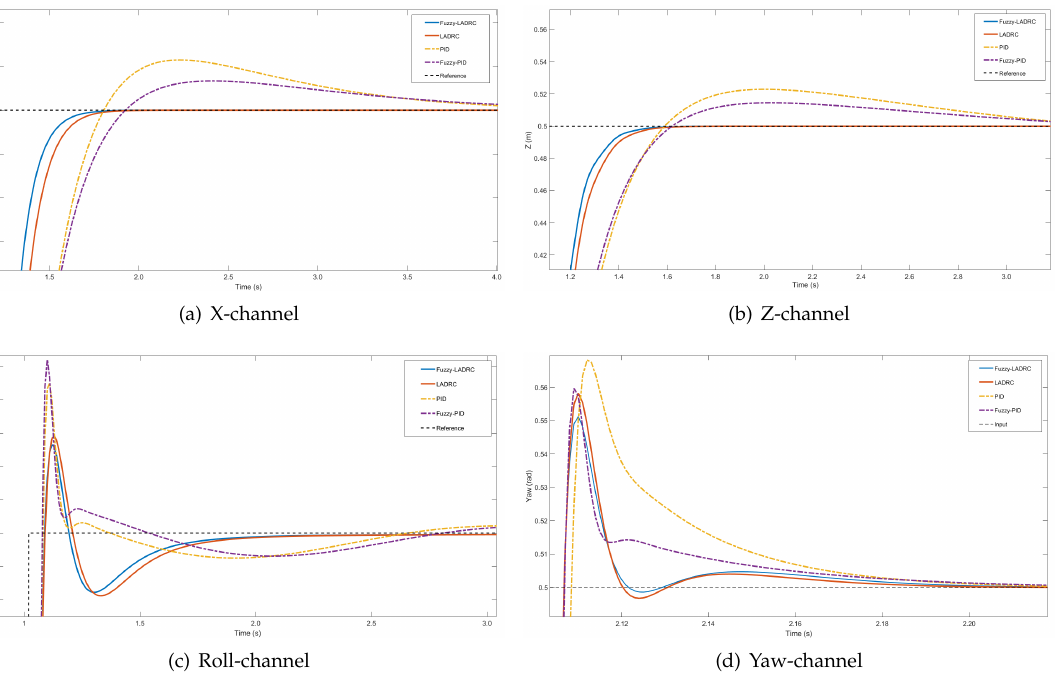
Figure 7. The results of tracking step